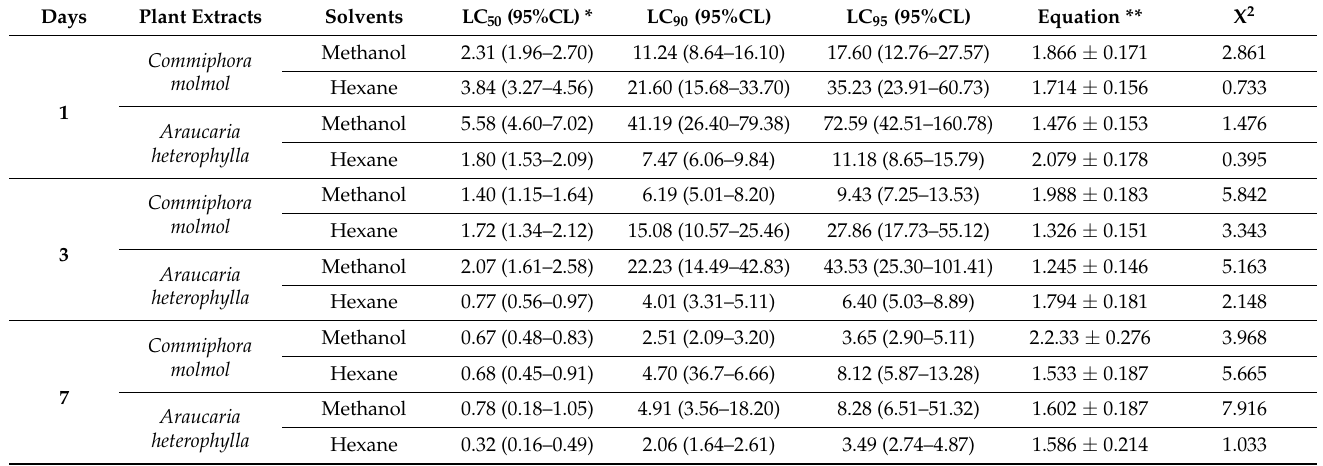
Table 8. Lethal concentrations of plant extracts of Commiphora molmol and Araucaria heterophylla against Hippobosca maculata